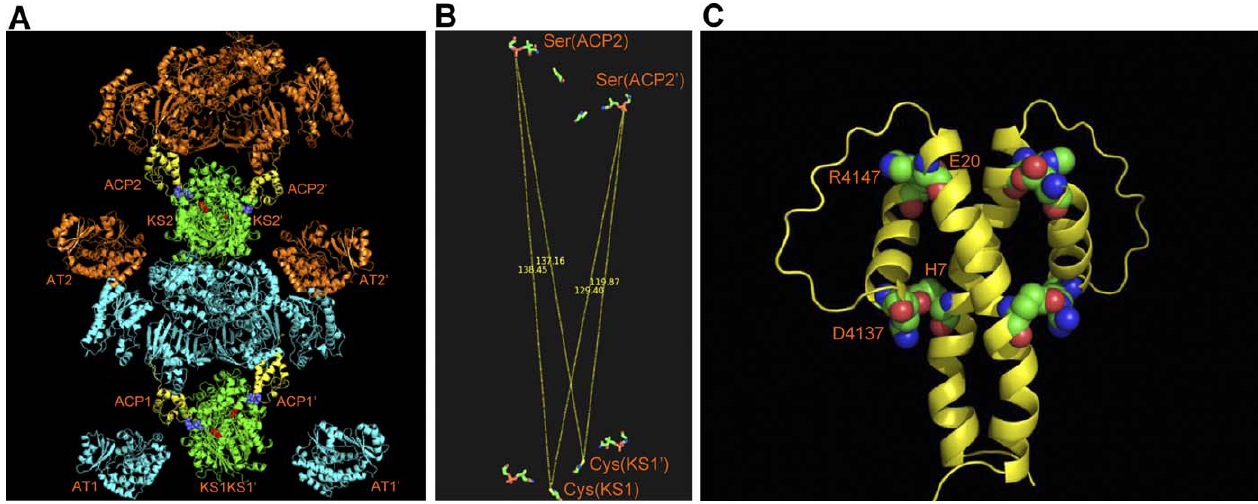
Figure 5. PKS12 Models and Identification of Interacting Residues (A) The end-to-end orientation of PKS12 is shown. Module 1 of PKS12 is shown in cyan and module two in copper brown, except the KS and ACP domains. The KS domains are shown in green and the ACP domains in yellow. (B) The active site residues of KS and ACP domains are shown in ball and stick, and the distances are shown. (C) Model for the docking domains of PKS12 generated by SCRWL and energy minimized using CVFF force field of Insight II. The interacting residues of the N- and the Cters are shown.